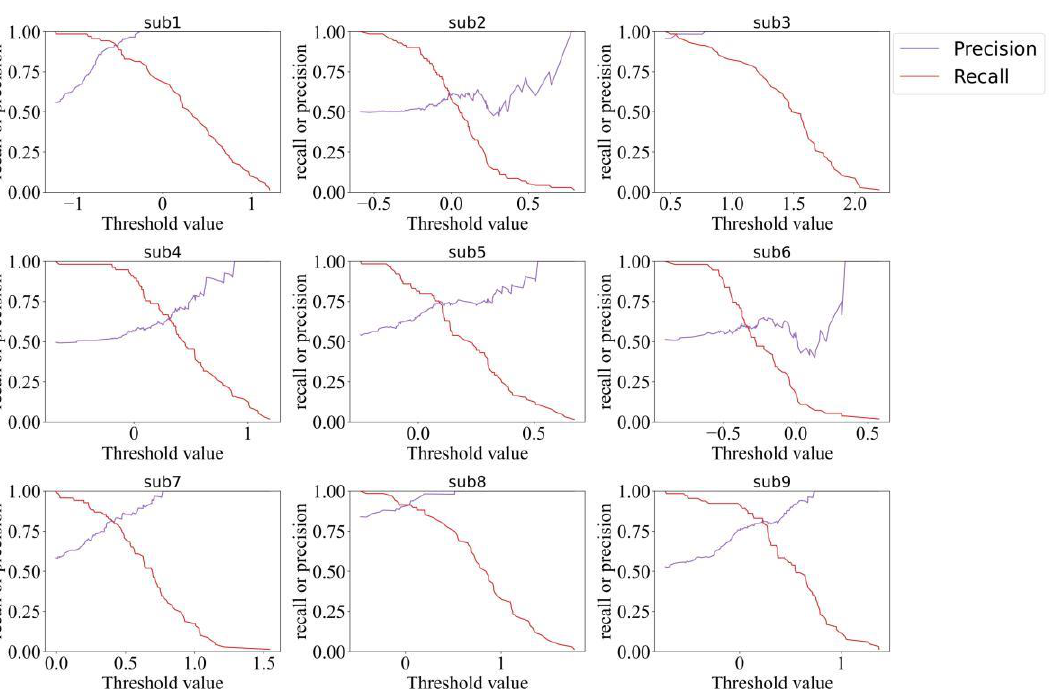
Figure 7. The precision and recall curves on nine subjects for selecting the optimal threshold value.